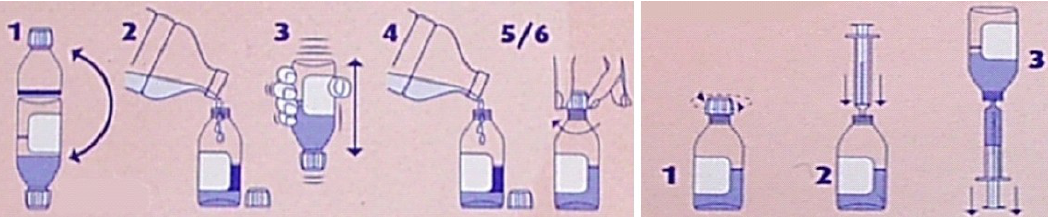
Figure 4. Pictograms explaining use of medicinal